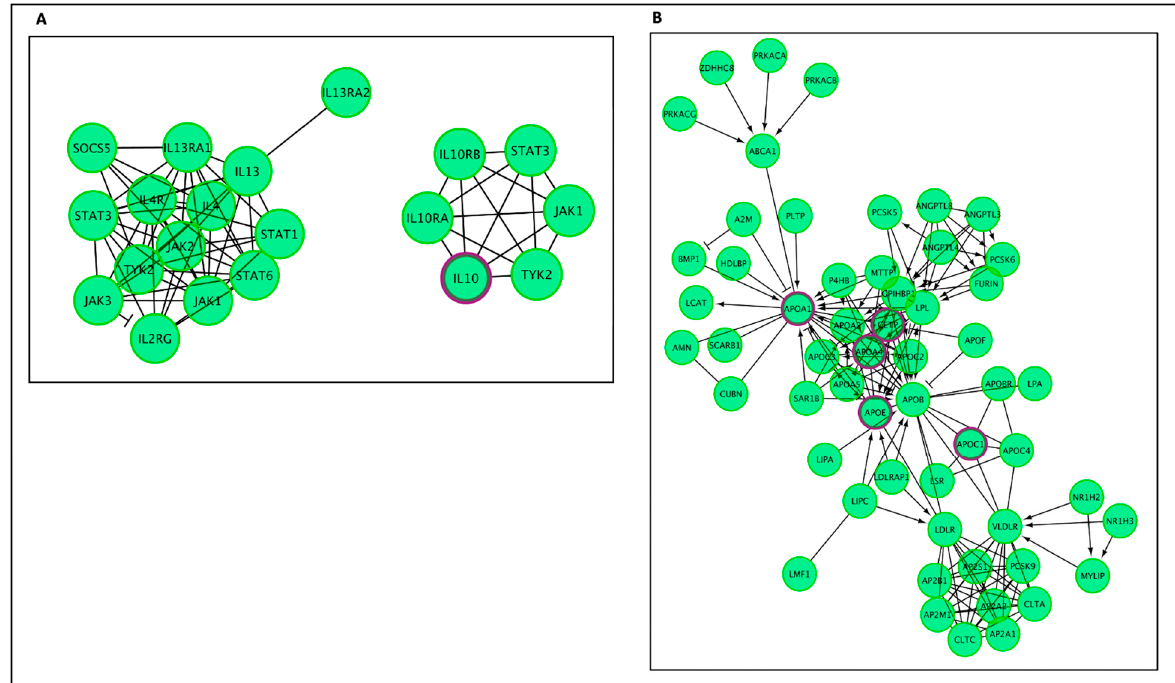
Figure 5. The Reactome pathways from Figure 4 converted into a functional interaction network. Hit genes are displayed with a purple border. ( A ) FI network for the diagram of Interleukin-4, Interleukin-13, and Interleukin-10 signaling, ( B ) FI network for the diagram of plasma lipoprotein assembly, remodeling, and clearance.